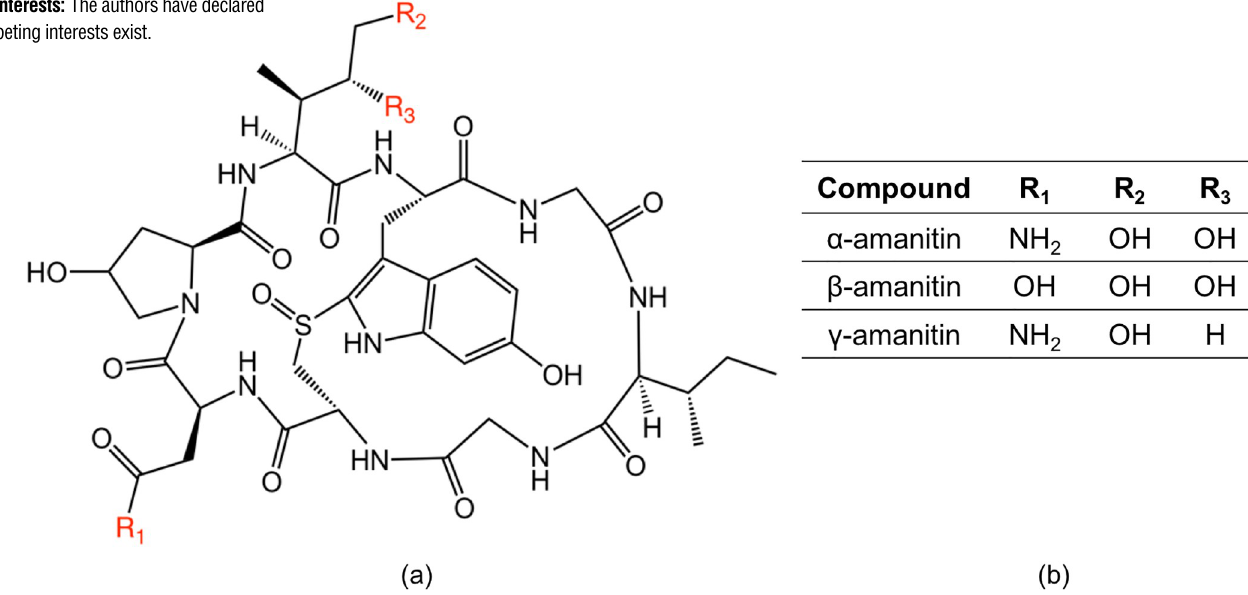
Fig 1. Chemical structures of the amatoxin variants examined in this paper. (a) molecular structure of amanitin. (b) R-group designations for each variant.